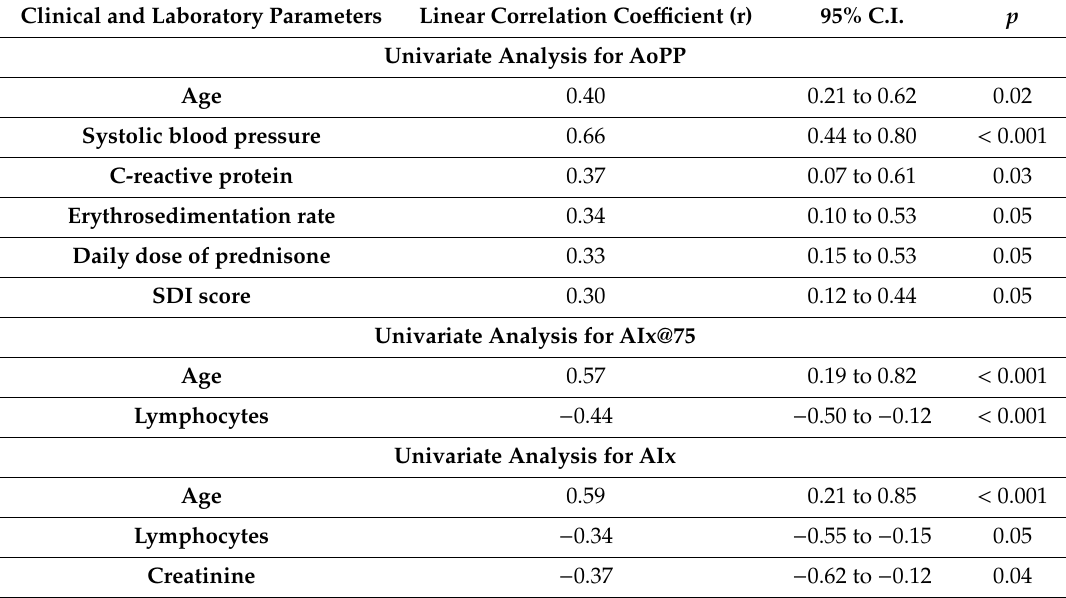
Collaborating Clinics / American College of Rheumatology Damage